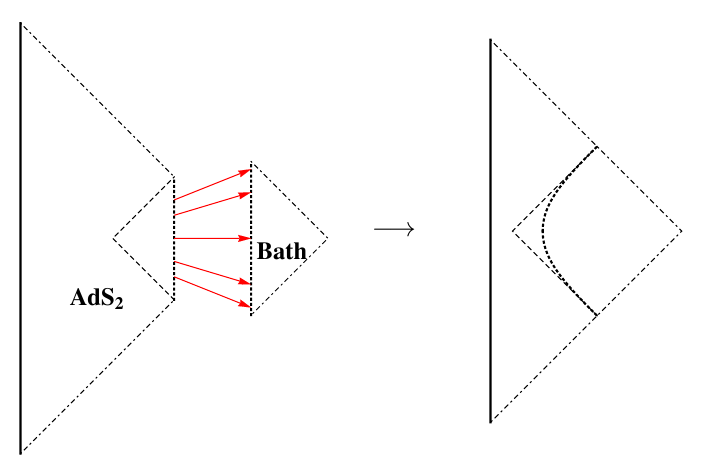
Figure 4 . Penrose diagrams of the identi(cid:12)cation for the time-symmetric coupled system. Only the future-half of the diagram is relevant to the physical system in which the coupling is switched on only at t = 0. At t = 0 the bath is prepared in the Minkowski half-line vacuum. Dash-dotted lines denote future and past null in(cid:12)nity in the relevant Minkowski space. The remaining bath boundary (dotted) is identi(cid:12)ed with the right boundary of AdS 2 using the di(cid:11)eomorphism f . We describe the state of the matter (cid:12)elds in the patch of AdS 2 shown, bounded by the dash-dotted lines denoting future and past Cauchy horizons. The dashed lines denote the event horizons of the right boundary. The resulting state is the half-line vacuum in the Minkowski half-space with auxiliary metric dwd (cid:22) w , for which the Penrose diagram is shown on the right. In the physically relevant limit w 0 ! 0, the worldline of the joined boundaries is pushed to the left in the w coordinates, becoming nearly